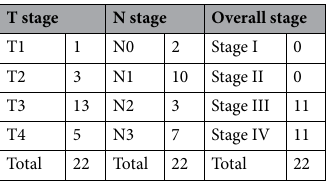
Table 1. The characteristics of patients with nasopharyngeal carcinoma (n =